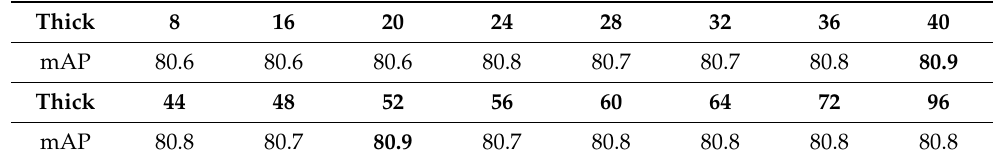
Figure 10. Comparison of three type of losses to Boundary Guided Supervision module (BGS). Table 7. Ablation performance of the thick with respect to BGS. Thick means the boundary pixel thickness on the input